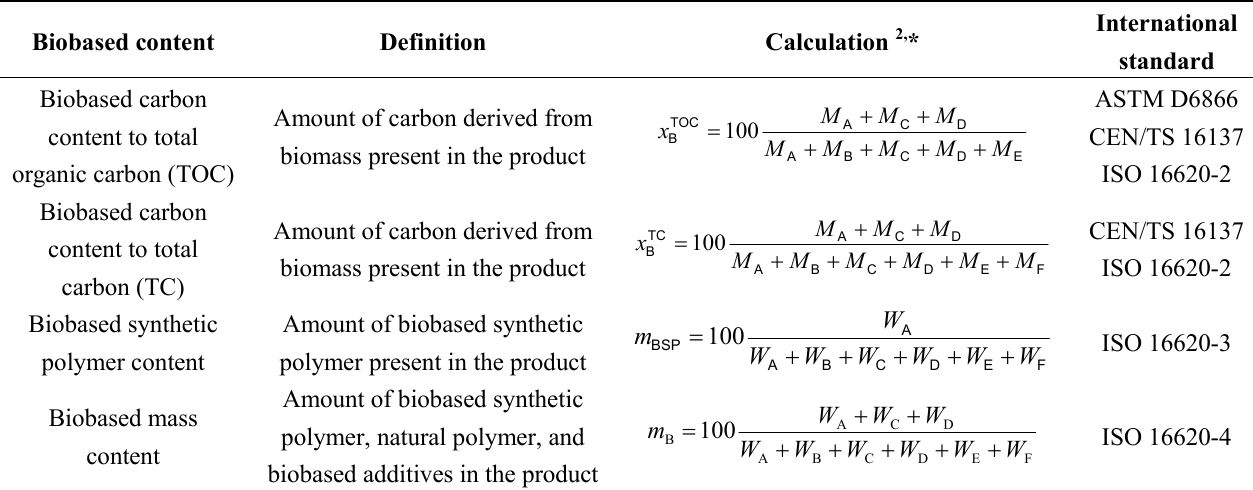
Table 2. Biobased content in plastic products 1, * .